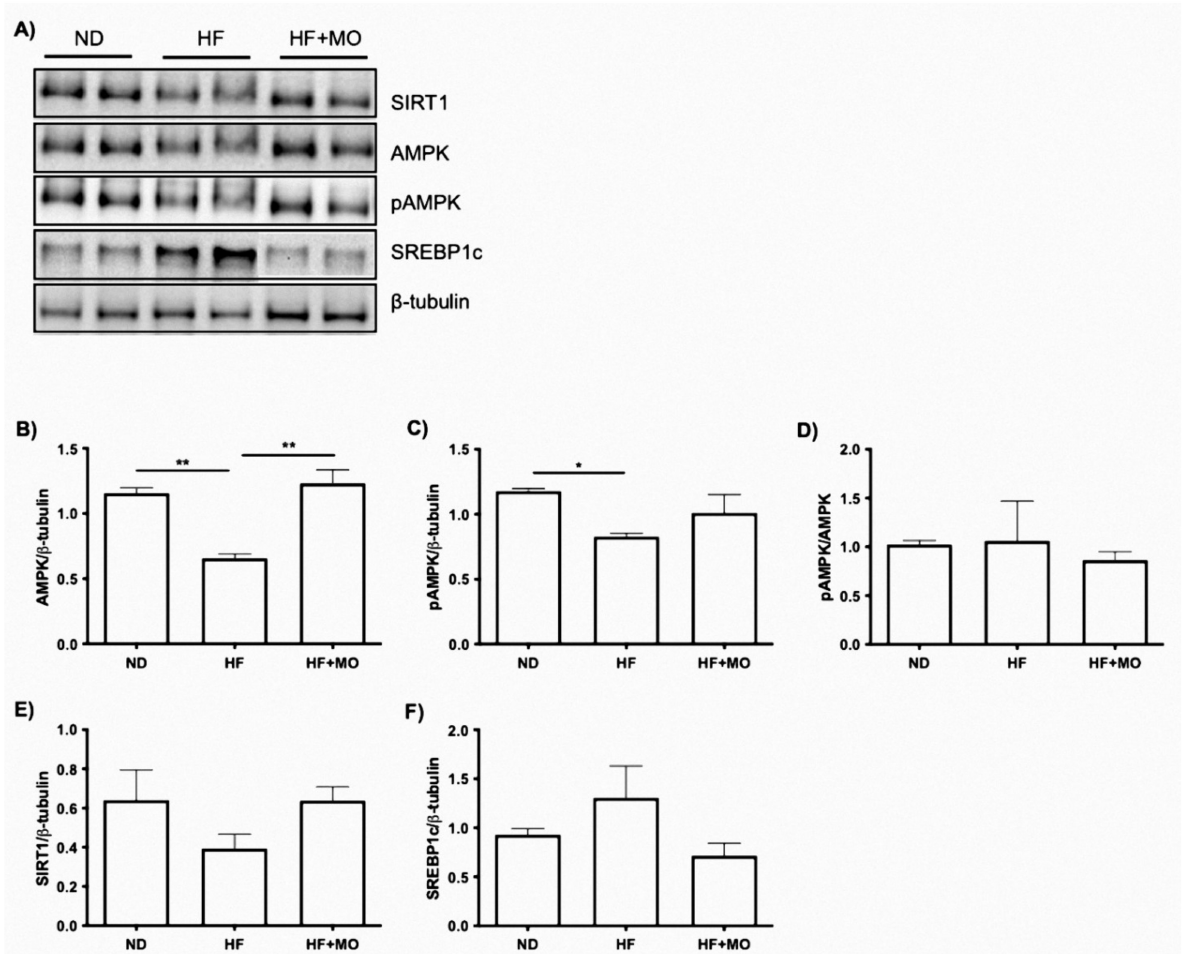
Figure 6. Effect of Moringa on the SIRT1/AMPK α /SREBP-1c/FAS signaling axis. ( A ) Representative image of the relative levels of protein of the SIRT1/AMPK α /p-AMPK α /SREBP-1c axis. ( B ) AMPK α ( C ) phosphorylated AMPK α , ( D ) Ratio p-AMPK α /AMPK α , ( E ) SIRT1, ( F ) and SREBP-1c. AMPK ( p < 0.01) and pAMPK are increased in Mo group. Data are expressed as mean ± SE. * p < 0.05; ** p <